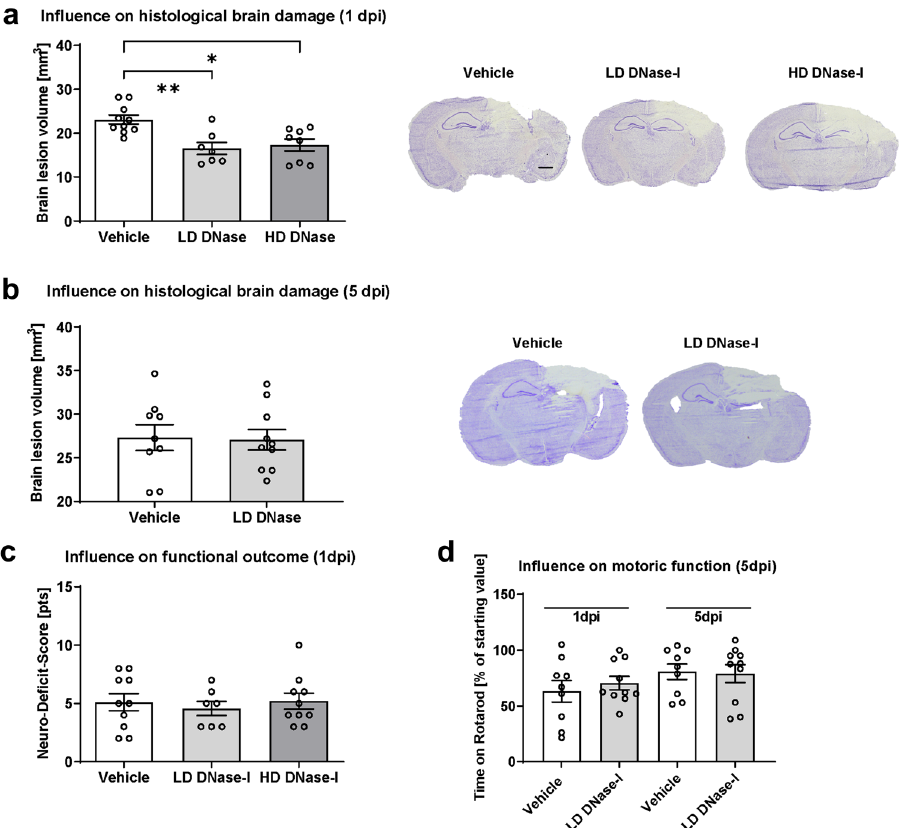
Figure 1. Effects of DNase-I injection on lesion size, neurological and motoric deficit after traumatic brain injury (TBI). ( a ) Brain lesion volume was determined 24 h (1 dpi) after controlled cortical impact (CCI) in mice treated with DNase-I low-dose or high dose (LD: 2 or HD: 18 m/kg) or vehicle (NaCl 0.9%) (n = 10 mice/ group) by intraperitoneal injection 30 min and 12 h post-insult. Both DNase-I doses significantly reduced brain lesion volume compared to vehicle at 1 dpi. ( b ) Lesion volume did not differ between groups at 120 h post-CCI (5 dpi). ( c ) Neurofunctional deficit score at 1 dpi did not differ among groups. ( d ) Motor function as assessed by rotarod performance was severely impaired 1 dpi but recovered markedly by 5 dpi without significant difference between treatment groups (n = 12 mice/group). A significance level p < 0.05 is marked with *, p < 0.01 with **, and p < 0.001 with ***. All data are presented as mean ± SEM; p values are adjusted for multiple comparisons by Sidak